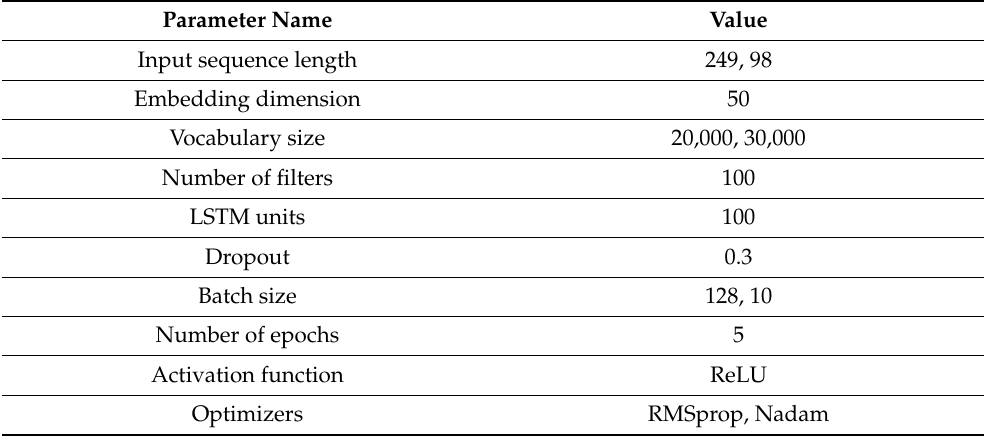
Table 1. Summary of the parameters used in the CNN-BiLSTM